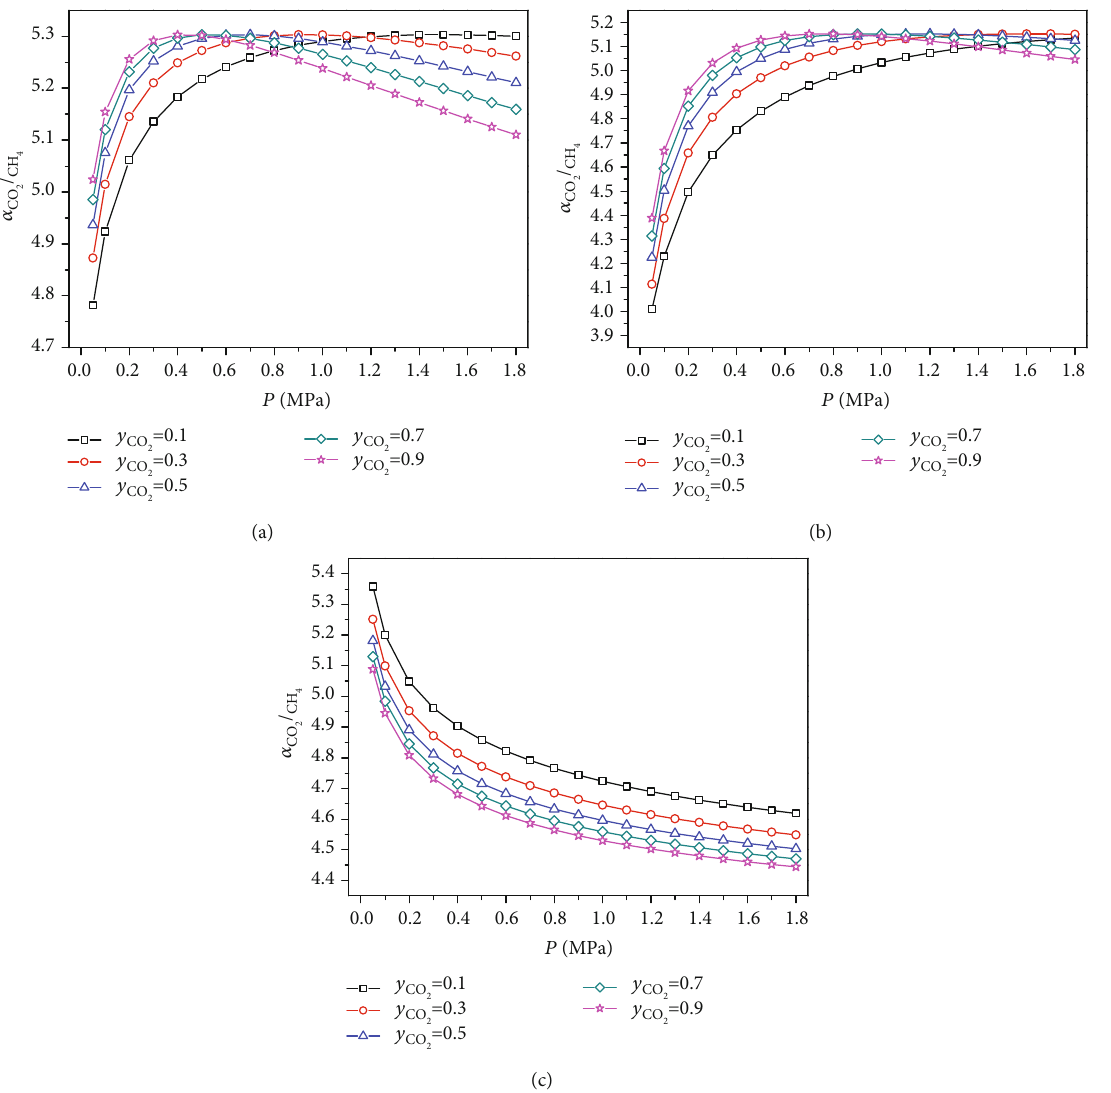
Figure 6: Predicted adsorption selectivity of CO